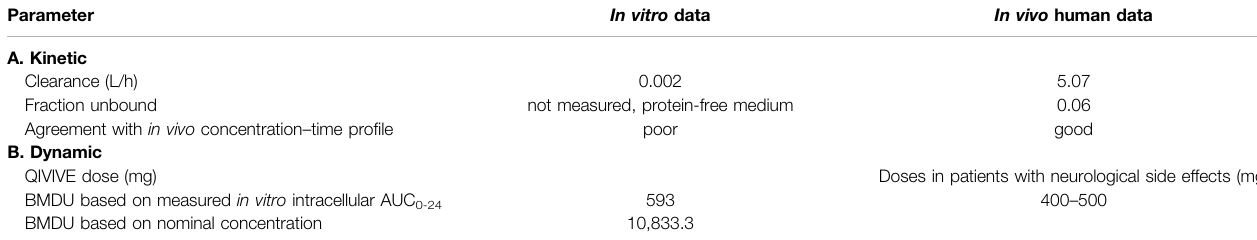
TABLE 3 | Case 2 — AMI - : Relevant data and results. Parameter